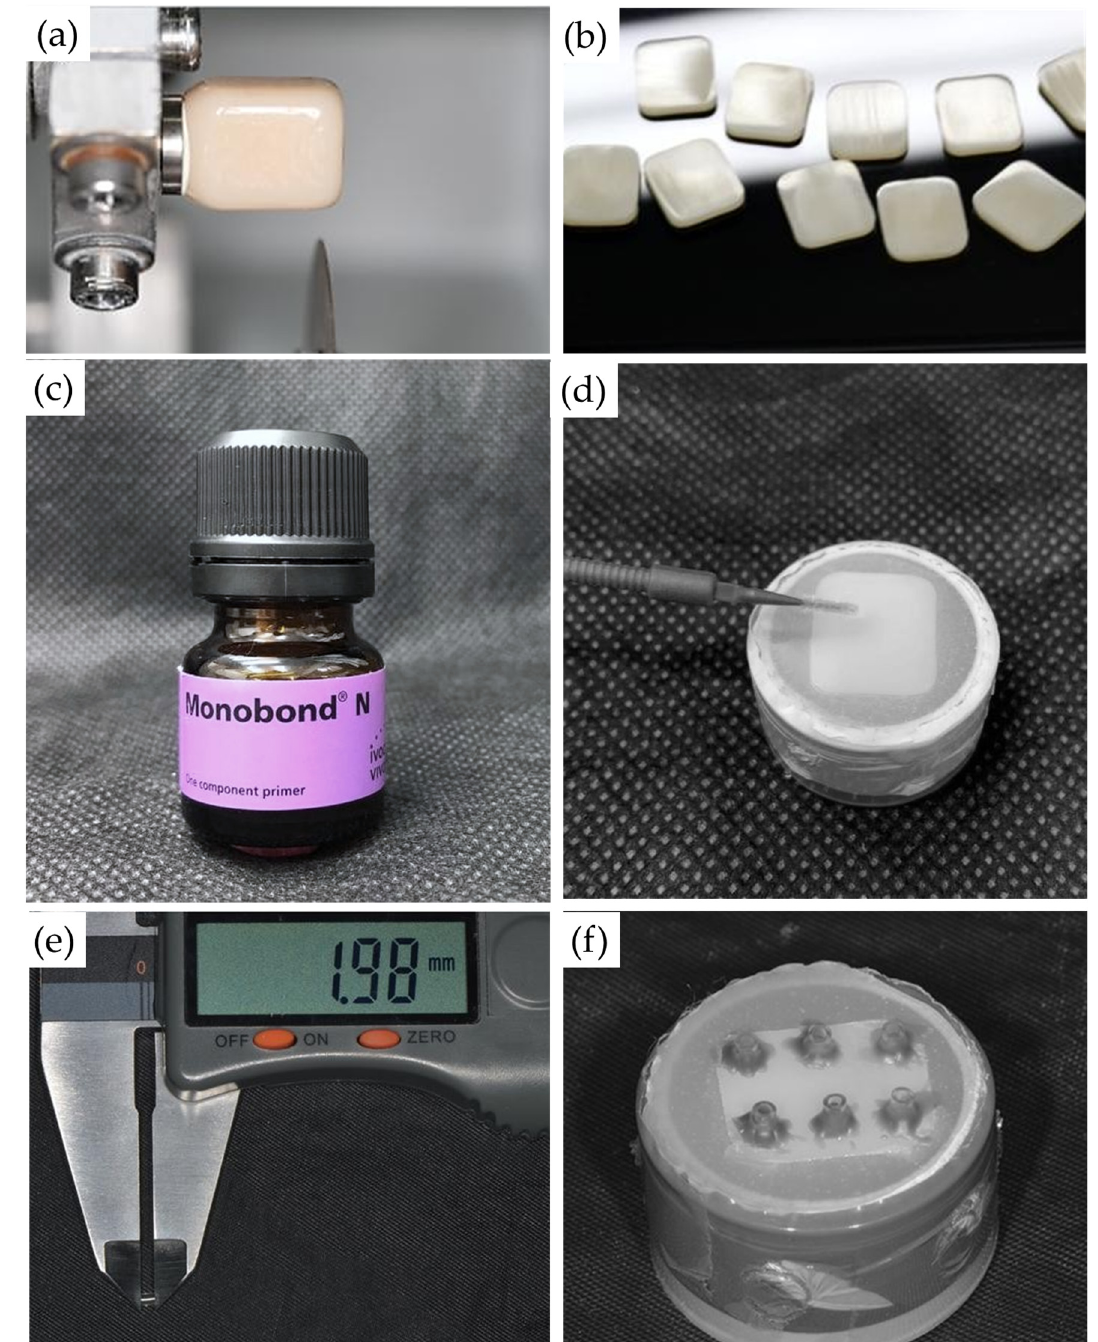
Figure 2. Specimen preparation. ( a ) Cutting the ceramic block at precision cutting machine, ( b ) standardized slices after cutting, ( c ) silane coupling agent used in this study, ( d ) application of silane coating on the etched ceramic surface, ( e ) cylindrical transparent matrices height, and ( f ) cylindrical transparent matrices fixed on the ceramic’s surface.